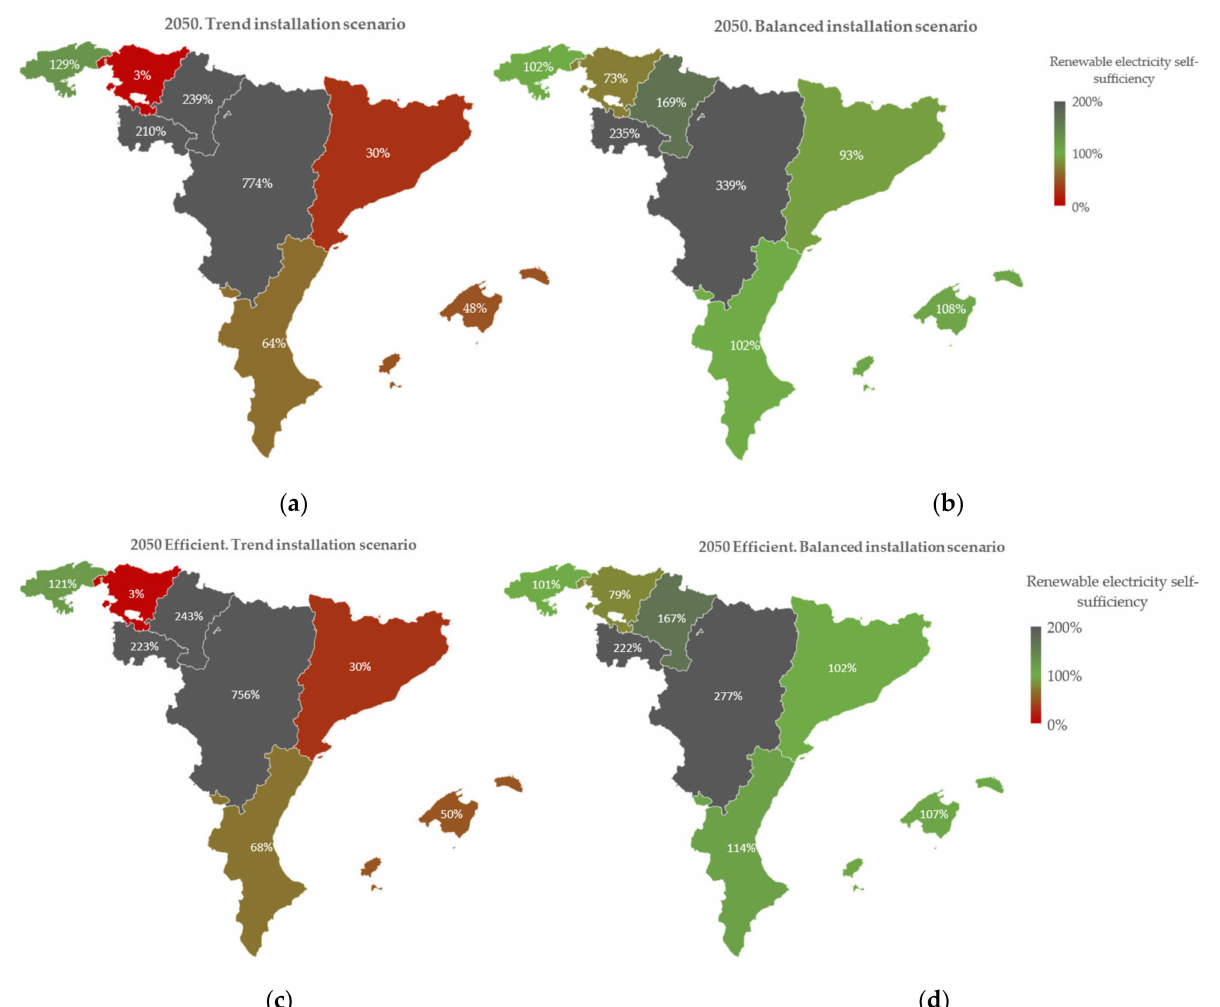
Figure 8. Renewable electricity self-sufficiency in 2050; ( a ) 2050, Trend scenario; ( b ) 2050, Balanced scenario; ( c ) 2050 Efficient, trend scenario; ( d ) 2050 Efficient, balanced